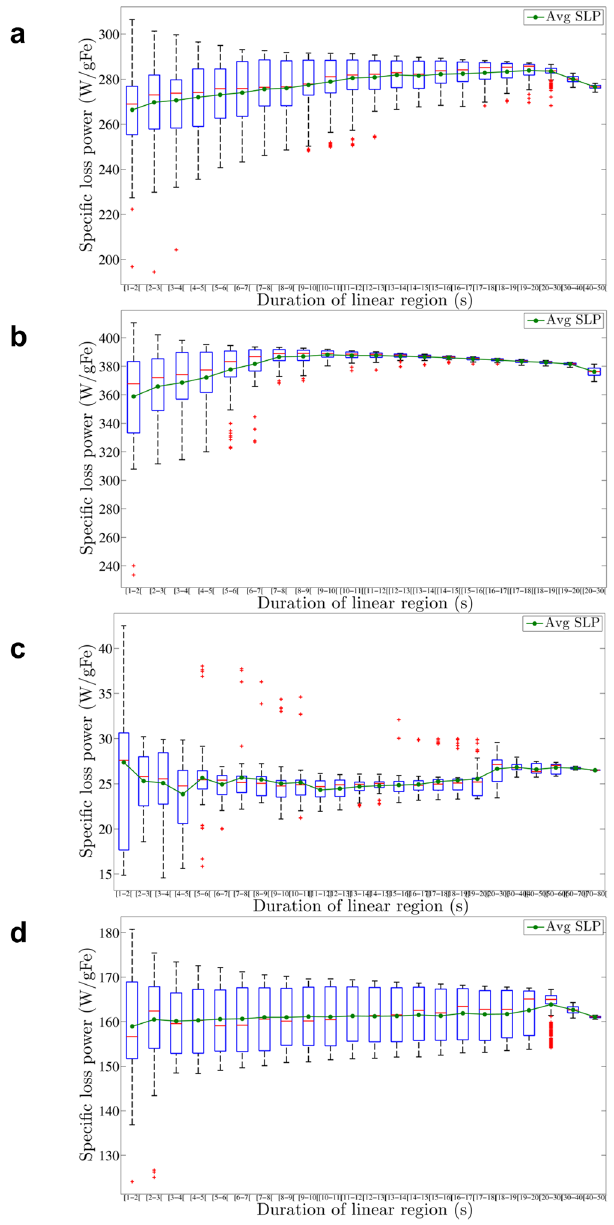
Figure 5. Possible SLP values, satisfying the (quasi)-adiabatic criterion, as a function of the time duration of the linear region (BNF-Dextran – 150 kHz and 20 kA/m ( a )). The smaller the chosen duration of the linear region, the larger the variation in SLP values. To reduce this variation, only durations longer than 6 seconds are included in the calculation. The average SLP value (green line) and variation for each time duration larger than 6 seconds are similar (maximum 5% difference from [6s–7s] to [40s–50s]). Analogous figures are depicted for JHU ( b ), nanomag ® -D-spio ( c ), and MnFe 2 O 4 nanoparticles ( d